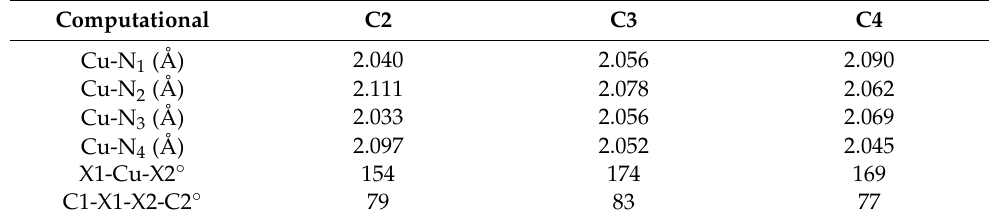
Table 2. Calculated parameters for C2 , C3 and C4 .